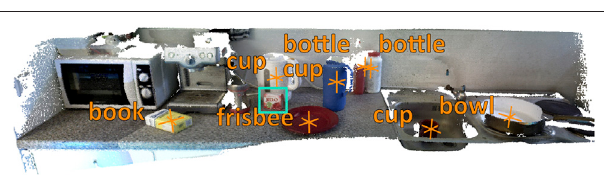
FIGURE 4 | 3D object map of detected objects using Mask R-CNN trained on COCO created with the approach from de Oliveira et al. (2021). Besides some background objects, all YCB objects are detected, except for the gelatin box (marked with cyan rectangle).